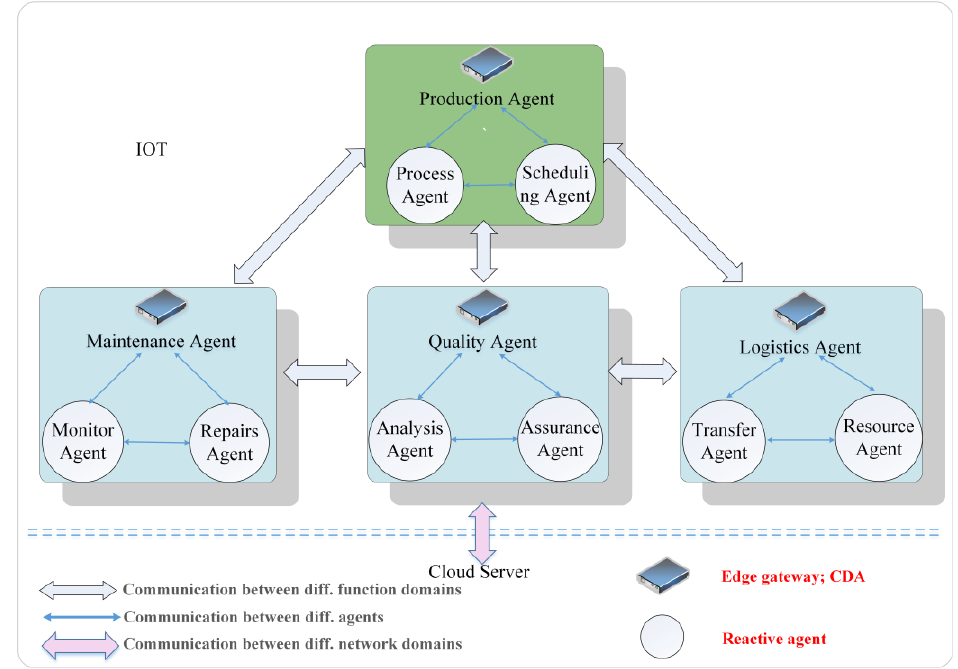
Figure 3. Schematic description of multi-agent architecture.